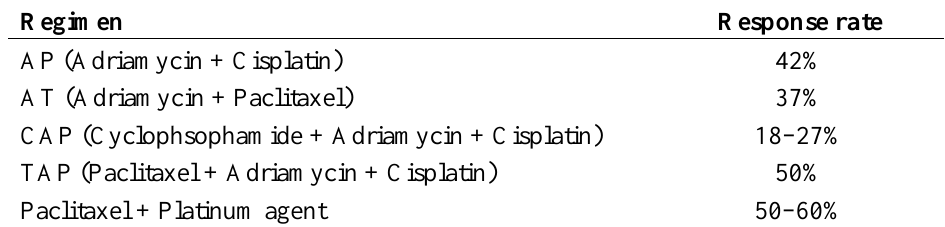
Table 3. Chemotherapy and response rate of serous endometrial